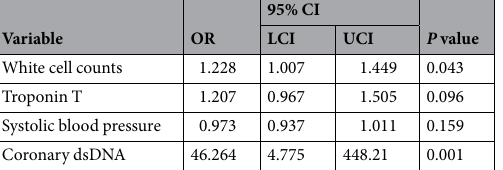
Table 4. Multivariable Logistic Regression Analysis for in-hospital MACEs. OR, odd ratio; CI confidence interval; LCI, low confidence interval; UCI, up confidence interval; MACEs: major adverse cardiac